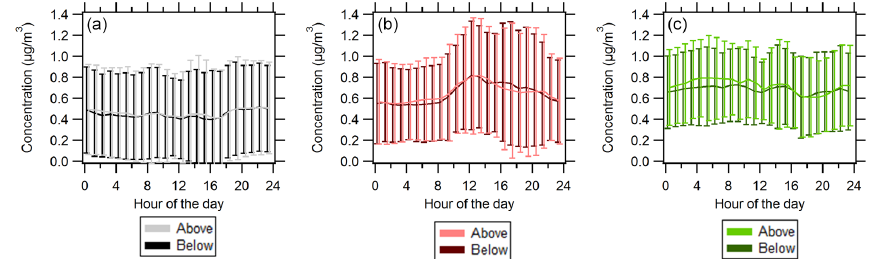
Figure 3. Diurnal profiles of (a) MO-OOA, (b) IEPOX-OA, and (c) 91Fac where solid lines represent average values and whiskers represent 1 standard deviation from the mean. Darker colors represent below-canopy OA (B-MO-OOA, B-IEPOX-OA, B-91Fac) while lighter colors represent above-canopy OA (A-MO-OOA, A-IEPOX-OA, A-91Fac). Data for below-canopy OA factors have been offset by 15min simply to aid plot